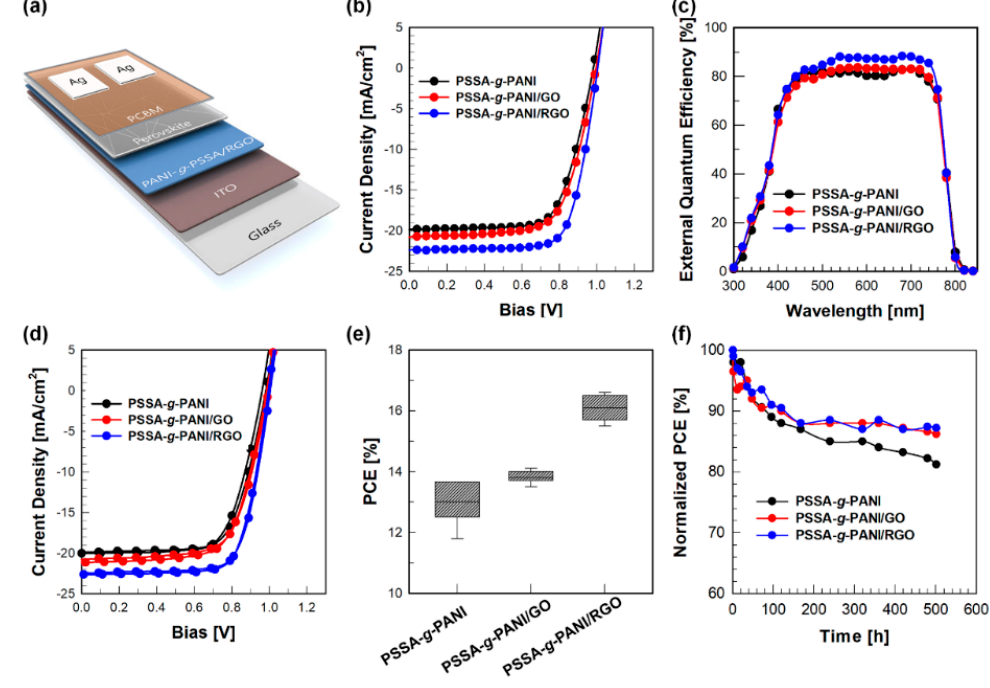
Figure 3. ( a ) Schematic device structure, ( b ) J-V curves under 1-sun illumination, ( c ) EQE spectra, ( d ) J-V curves under 1-sun illumination with different scan directions, ( e ) statistical analysis of PCEs, and ( f ) PCE decay under ambient storage of the PSCs with the composite HTLs. Table 1. Photovoltaic parameters of devices with varied HTL composites under 1-sun illumina- tion.